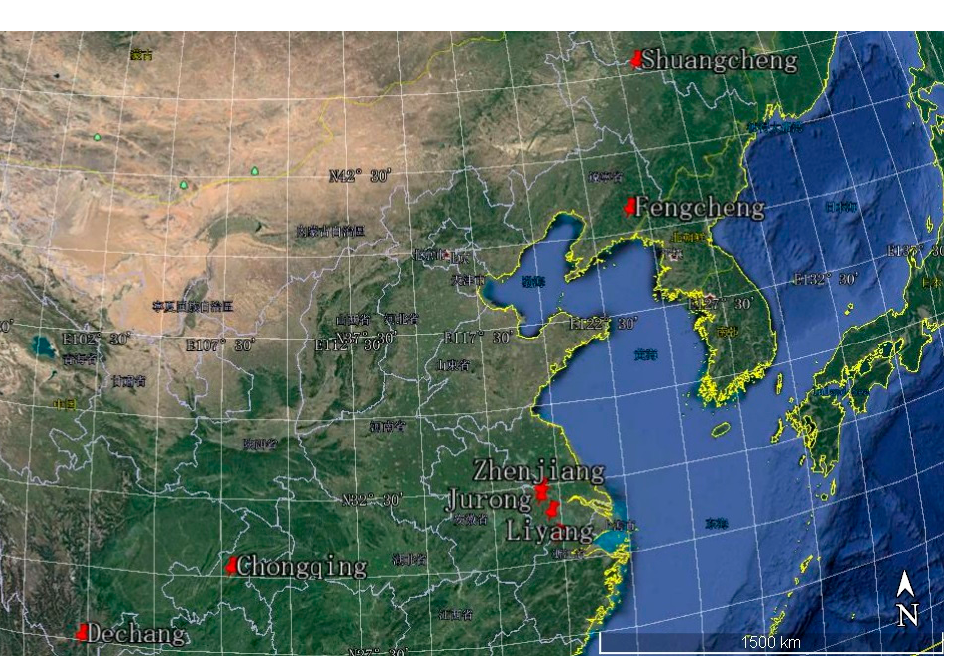
Figure 5. Different collection area of mulberry fruit ( Morus alba L.) in China. Chinese means province in China.